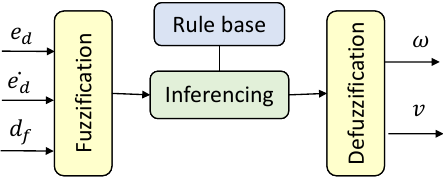
Figure 2. Architecture of the Type 1 Fuzzy Logic System